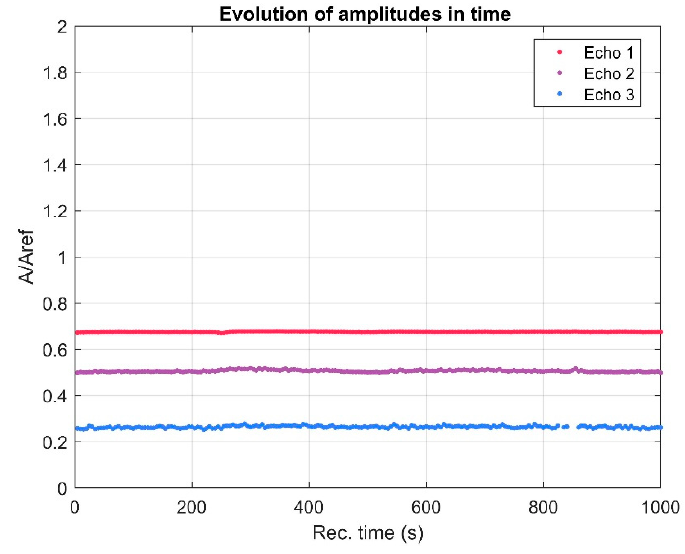
Figure 3. Evolution in time of the echo amplitudes.